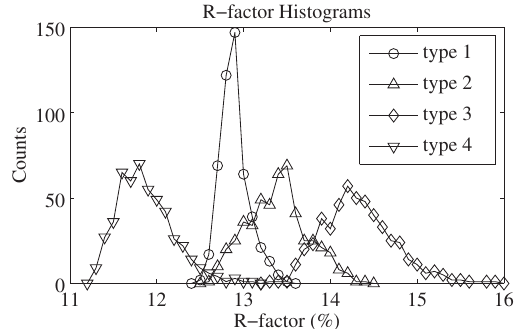
FIG. 8. R -factor histograms formed from 500 independent phasing trials.